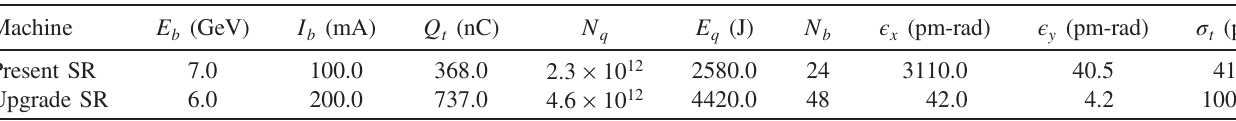
COLLIMATOR IRRADIATION STUDIES IN THE TABLE II. Basic timing-mode beam and machine parameters for the present APS SR and upgrade SR, including beam energy, E b , beam current, I b , total charge, Q t , total electron number, N q , stored energy, E q , number of bunches, N b , transverse emittances, ϵ x and ϵ y , and rms bunch duration, σ t .